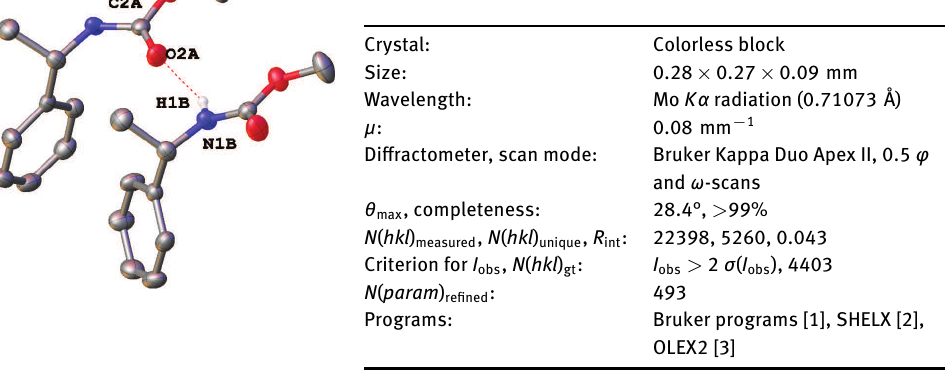
Table 1: Data collection and